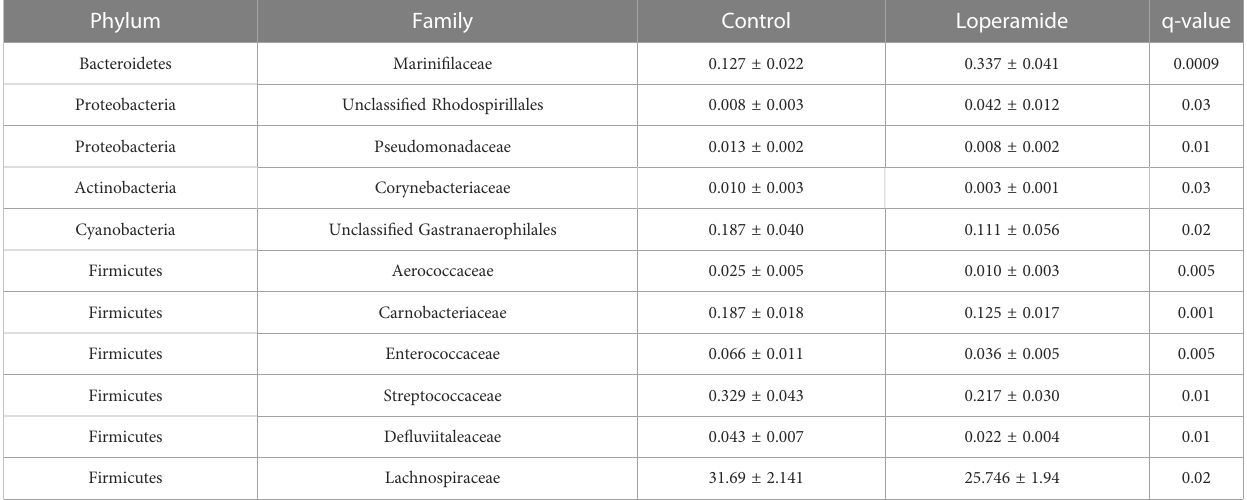
TABLE 1 Families with signi fi cantly different relative abundances between loperamide- treated and control rats. Data represented as mean percent ± standard error of mean